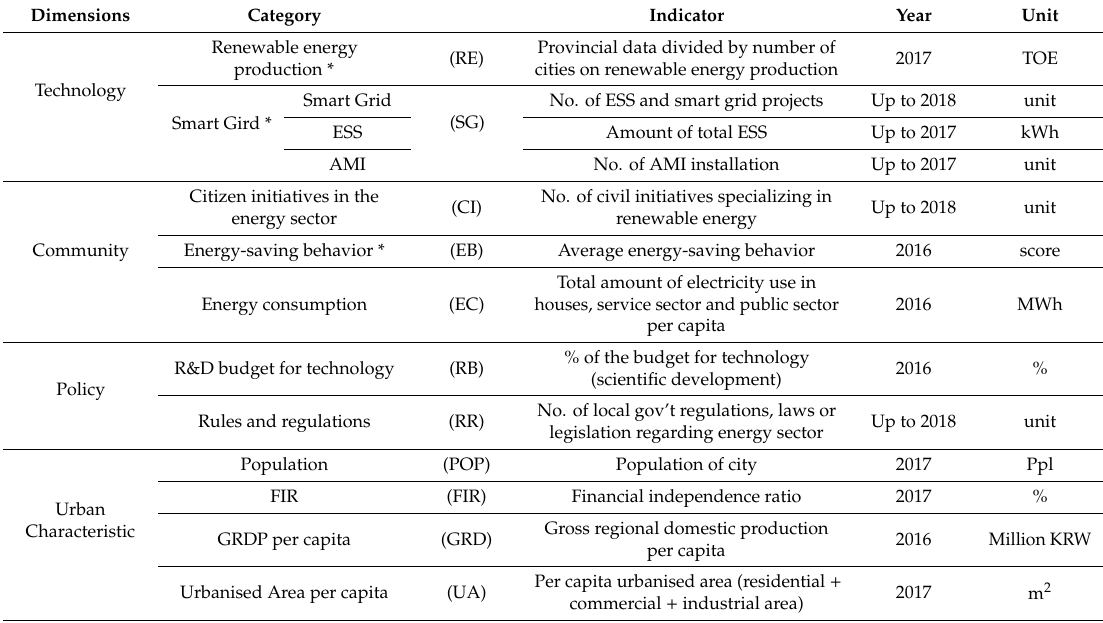
Table 6. Indicators for the Smart Energy Transition